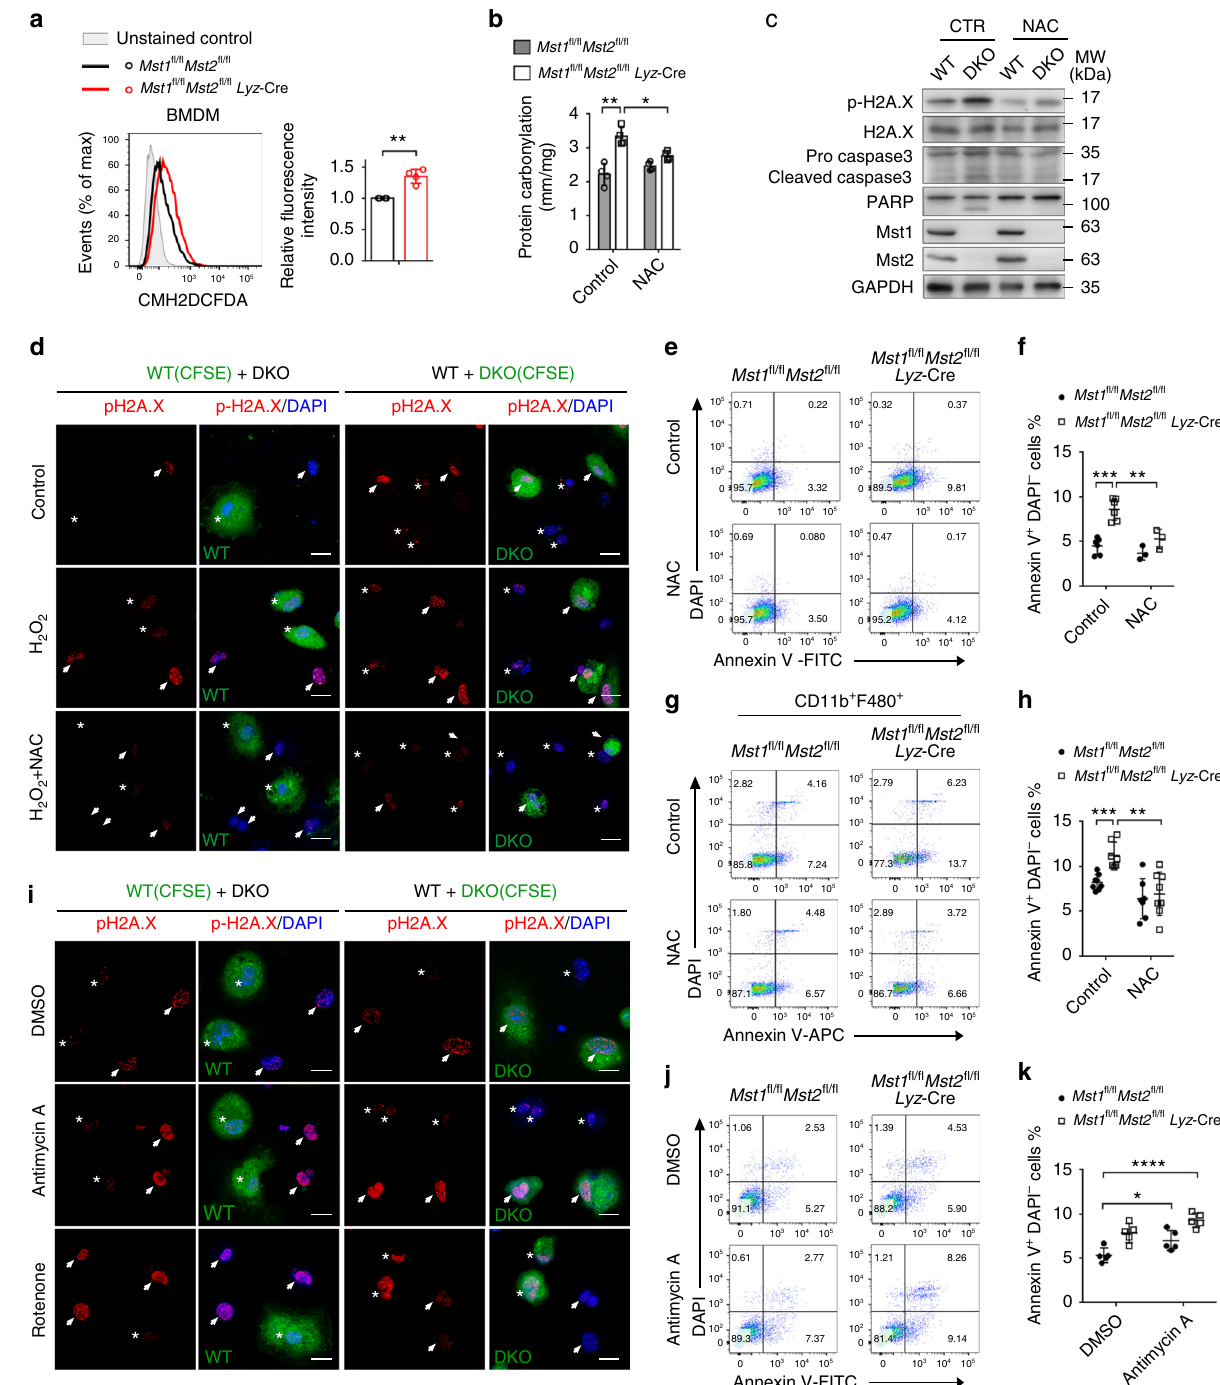
Fig. 1 Increased ROS levels and apoptotic events in Mst1/2-null macrophages. a Flow cytometry of Mst1 fl / fl Mst2 fl / fl (WT) and Mst1 fl / fl Mst2 fl / fl Lyz -Cre (DKO) BMDMs stained for 30min with the ROS dye CM-H2DCFDA. Quanti fi cation of the relative fl uorescence intensity in the indicated cell samples is shown in the right panel. b , c Quanti fi cation of protein carbonylation levels ( b ) and immunoblot analysis of phosphorylated (p)-H2A.X (Ser139), H2A.X, pro- and cleaved- caspase 3, PARP, Mst1, Mst2, and GAPDH ( c ) in WT and DKO BMDMs pretreated with or without NAC. d Fluorescence microscopy of p-H2A.X staining (red) and DAPI − stained nuclei (blue) in WT BMDMs (left) or DKO DMDMs (right) labeled with CFSE, mixed with unlabeled DKO BMDMs (arrows) or WT BMDMs (stars), and treated with H 2 O 2 and NAC as indicated. Scale bars, 20 μ m. e , f Annexin V/DAPI staining ( e ) and quanti fi cation of Annexin V + DAPI − cells ( f ) among WT and DKO BMDMs pretreated with or without NAC. g , h Flow cytometry ( g ) and quanti fi cation ( h ) of the percentage of Annexin V + DAPI − cells among WT and DKO CD11b + F4/80 + cells pretreated with or without NAC. i Fluorescence microscopy of p-H2A.X staining (red) and DAPI-stained nuclei (blue) in WT BMDMs (left) or DKO DMDMs (right) labeled with CFSE, mixed with unlabeled DKO BMDMs (arrows) or WT BMDMs (stars), and treated with DMSO, antimycin A or rotenone. Scale bars, 20 μ m. j , k Annexin V/DAPI staining ( j ) and quanti fi cation of Annexin V + DAPI − cells ( k ) among WT and DKO BMDMs treated with DMSO or antimycin A. * P <0.05, ** P <0.01, *** P <0.001, **** P <0.0001 compared with control (Student ’ s t test). Data are from one experiment representative of three independent experiments with similar results (mean and s.d. of n = 3 ( f ), n = 4 ( a , b ), n = 5 ( k ) or n = 8 ( h ) biological